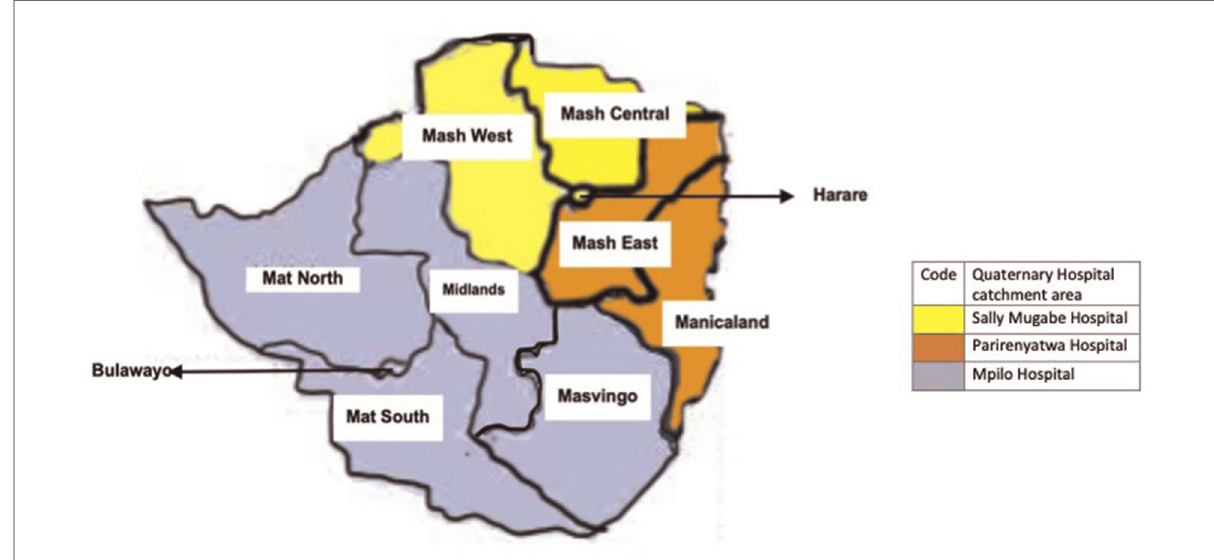
FIGURE 1 Map showing hospital catchment areas for neurosurgical patients in